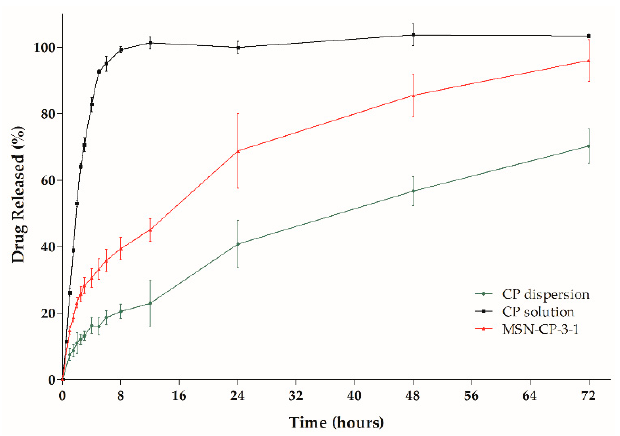
Figure 4. Clobetasol propionate (CP) in vitro release profile from: CP-loaded MSN (MSN-CP-3-1) and non-encapsulated CP (ethanolic solution and crystalline CP dispersion) ( n = 3). These differences can be better understood by comparing the DE of the samples, whose values were calculated as 40.79 ± 4.75%, 65.70 ± 6.52% and 97.40 ± 1.81%, for the CP dispersion, MSN-CP-3-1 and ethanolic CP solution, respectively. A clear enhancement in the DE of the drug-loaded MSN (MSN-CP-3-1) ( p ≤ 0.05) was observed compared to the crystalline CP suspension.